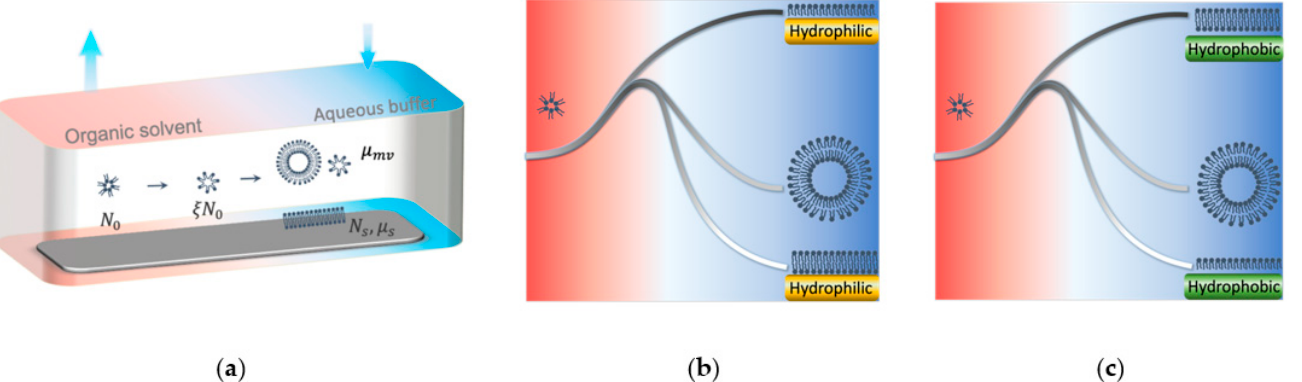
Figure 1. Schematic illustrations of Gibbs free energy profile along the solvent exchange coordinate path during the SALB formation process. ( a ) Schematic diagram of SLB formation pathway in the SALB method. ( b ) Expected Gibbs free energy profiles when inverted micelles disassemble and reorganize into different lipid structures in the system with a hydrophilic substrate during solvent exchange. ( c ) Expected Gibbs free energy profiles when inverted micelles disassemble and reorganize into different lipid structures in the system with a hydrophobic substrate during solvent exchange.